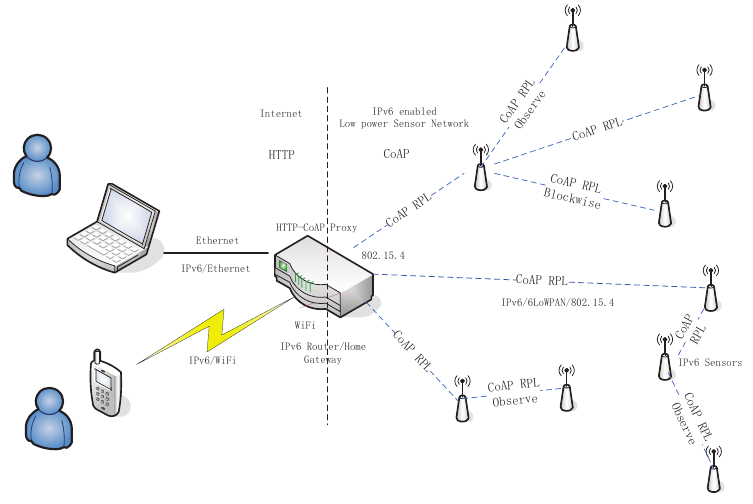
Figure 4. System Architecture